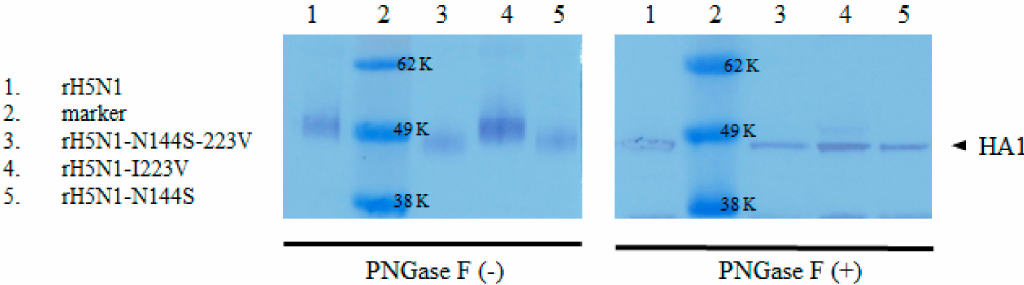
Figure 6. Verification of 144N-glycosylation by Western blotting. Recombinant viruses untreated and treated with PNGase F enzyme were denatured and separated by SDS-PAGE. Transferred membranes were incubated with rabbit anti-influenza A H5N1 (A / Vietnam / 1194 / 2004) HA IgG, followed by goat anti-rabbit IgG HRP-conjugated secondary antibody. Then, HRP was developed by TMB substrate. HA proteins of rH5N1 and rH5N1-I223V had 144N-glycan, and they had higher molecular weight than rH5N1-N144S and rH5N1-N144S-I223V in the absence of PNGase F enzyme treatment ( − ). However, the di ff erence disappeared after treatment of PNGase F enzyme ( +